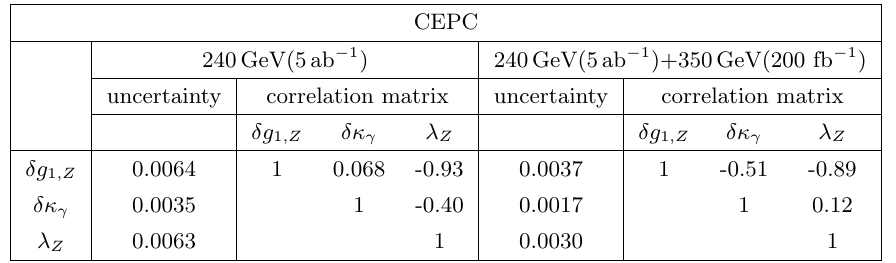
measurement at CEPC using the (cid:0) ! WW